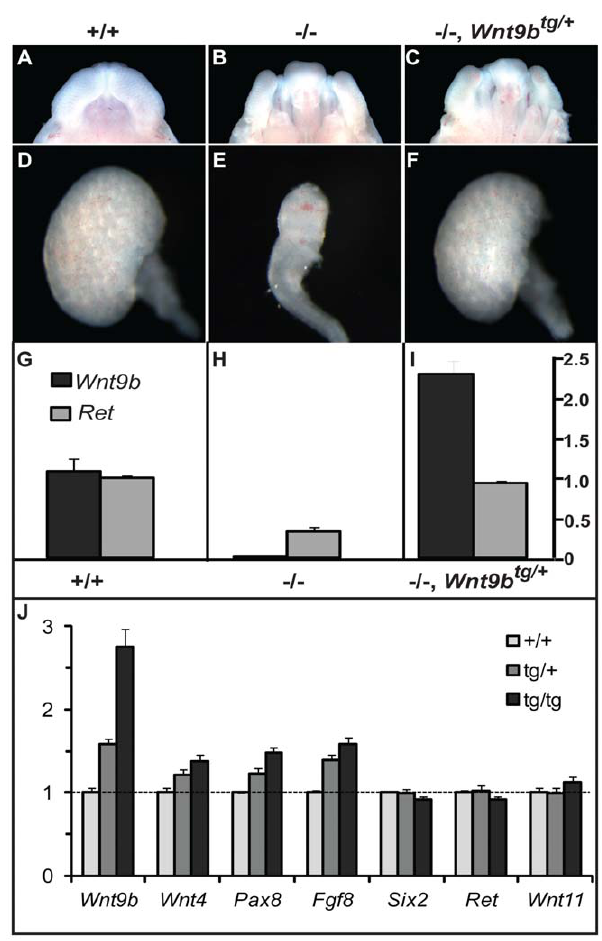
Figure 2. Transgenic Wnt9b is biologically active and can induce expression of renal vesicle genes. (A–F) Transgenic Wnt9b can rescue kidney formation in Wnt9b 2 / 2 E14.5 embryos. Wnt9b 2 / 2 embryos exhibit cleft palate (B) and kidney agenesis (E). Kidney-specific expression of the Wnt9b transgene with Hoxb7 -cre rescues kidney formation (F), but not palate closure (C) in the Wnt9b 2 / 2 mutant. (G–I) Quantitative PCR analysis shows that the Wnt9b transgene is expressed 2.3-fold higher than wild-type Wnt9b . J) Wnt9b and the renal vesicle genes ( Wnt4 , Pax8 , Fgf8 ) are increased in a dose-dependent fashion in wild-type ( Hoxb7-cre tg/ + ), hemizygous ( Hoxb7-cre tg/ + , Wnt9b tg/ + ), and homozygous ( Hoxb7-cre tg/ + , Wnt9b tg/tg ) E12.5 embryonic kidneys (p , 0.05 for all pairwise comparisons except Wnt4 hemizygous vs. homozygous (p=0.08). This is consistent with Wnt9b’s role in signaling from the ureteric bud to induce renal vesicle differentiation in the mesenchyme. A gene expressed in the metanephric mesenchyme and not in renal vesicles ( Six2 ) is unaffected by the Wnt9b transgene. Ureteric bud markers Ret and Wnt11 are also unchanged.